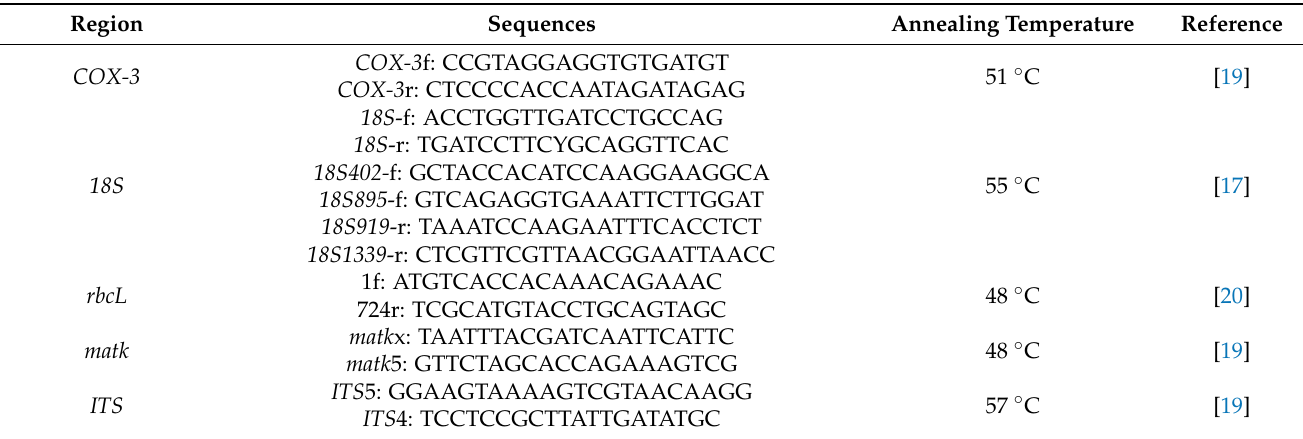
Table 1. List of specific primers used for PCR